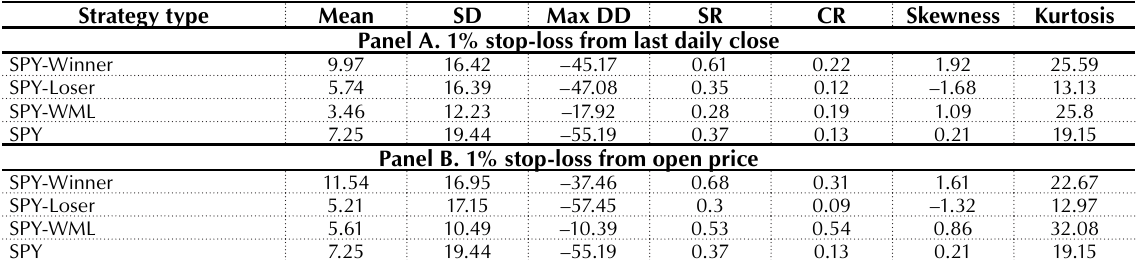
Table 1. SPY summary statistics with daily stop loss January 1, 2004 – October 13, 2015 Strategy